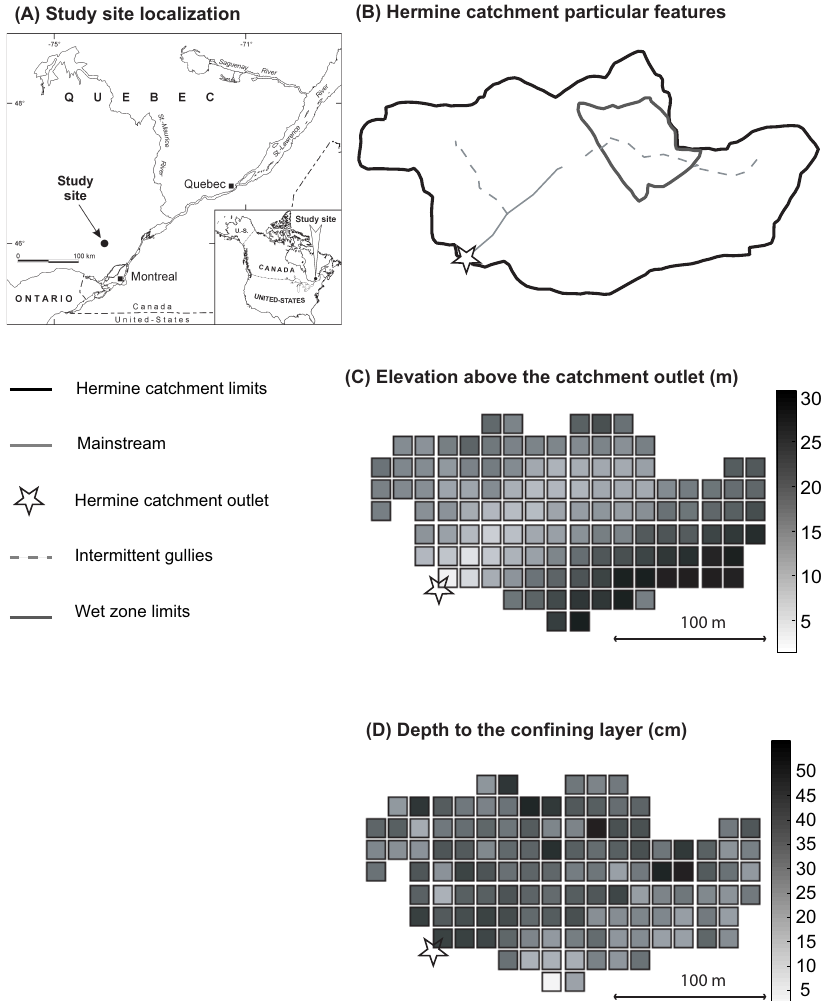
Fig. 1. (A) Location of the Hermine catchment; (B) Hermine catchment particular features; (C) Elevation above the catchment outlet; and (D) Depth to the confining layer for each of the 121 soil moisture sampling